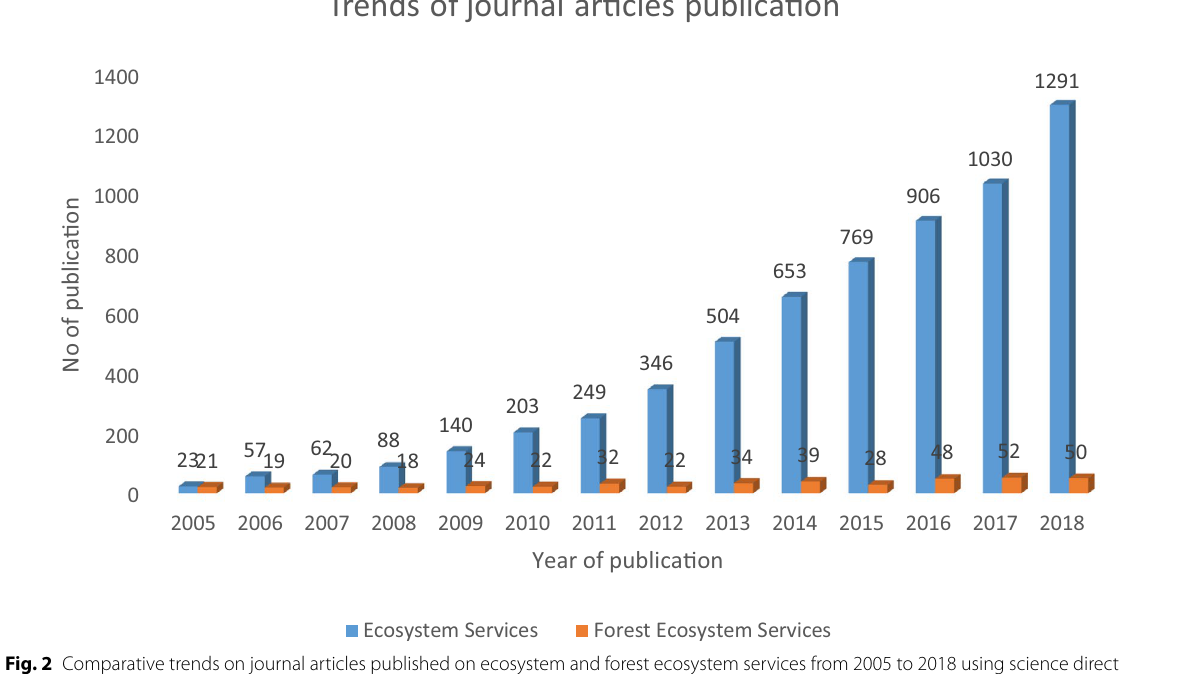
Fig. 2 Comparative trends on journal articles published on ecosystem and forest ecosystem services from 2005 to 2018 using science direct database. According to the data source of science direct since 2005 to 2018, more number of articles were published on ecosystem services mainly after the publication of the Millennium Ecosystem Assessment. The publication linked to forest ecosystem services are not that increasing like the